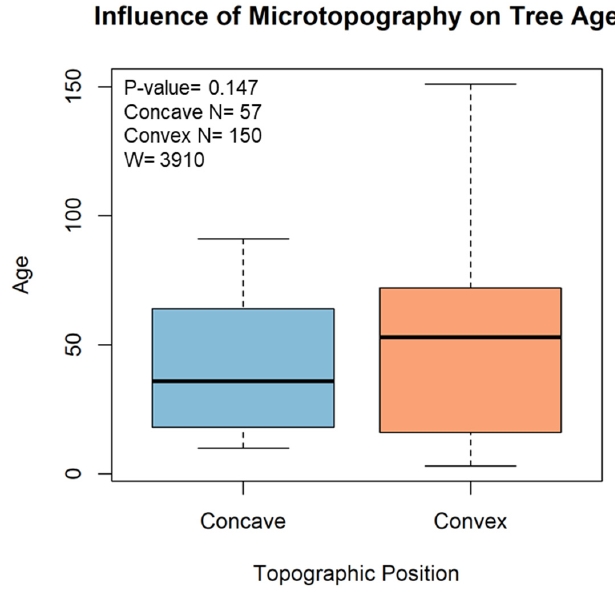
Figure 11. The difference in the age of trees between concave and convex plots.